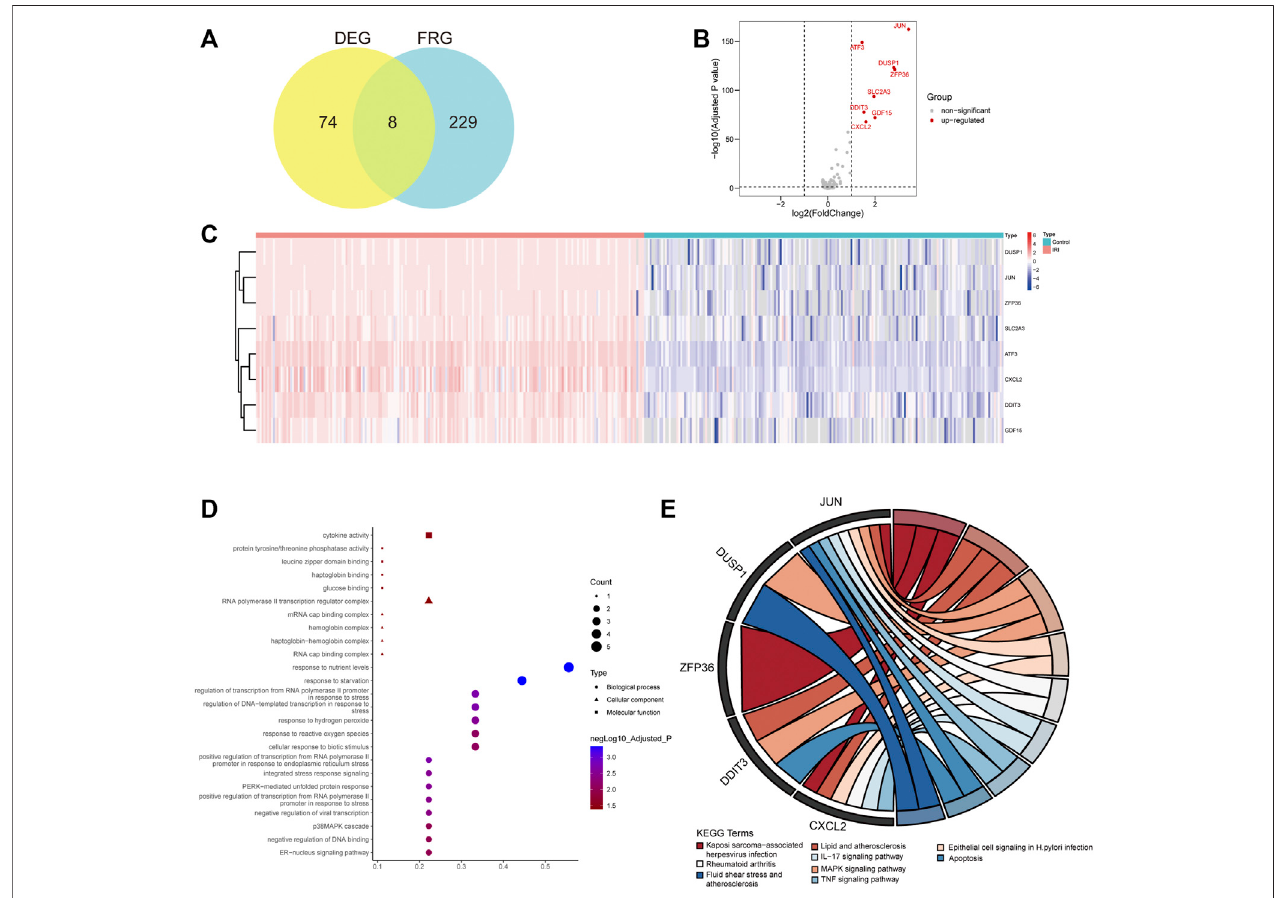
FIGURE2| Differentialexpression analysisand functional enrichmentanalysisofFRGs. (A) IntersectionbetweenFRGsand differentiallyexpressed genes(DEG)in renal IRI. (B) Volcano plot showing log2 (fold change) and adjusted P value of differentially expressed FRGs (DFRG). The gene symbols of DFRGs were labeled. (C) Heatmap showing the expression of DFRGs in the IRI group compared with the control group. (D) GO enrichment analysis of DFRGs in terms of biological process, cellular component, and molecular function. (E) KEGG pathway analysis of DFRGs. Terms with adjusted p < 0.05 were selected.